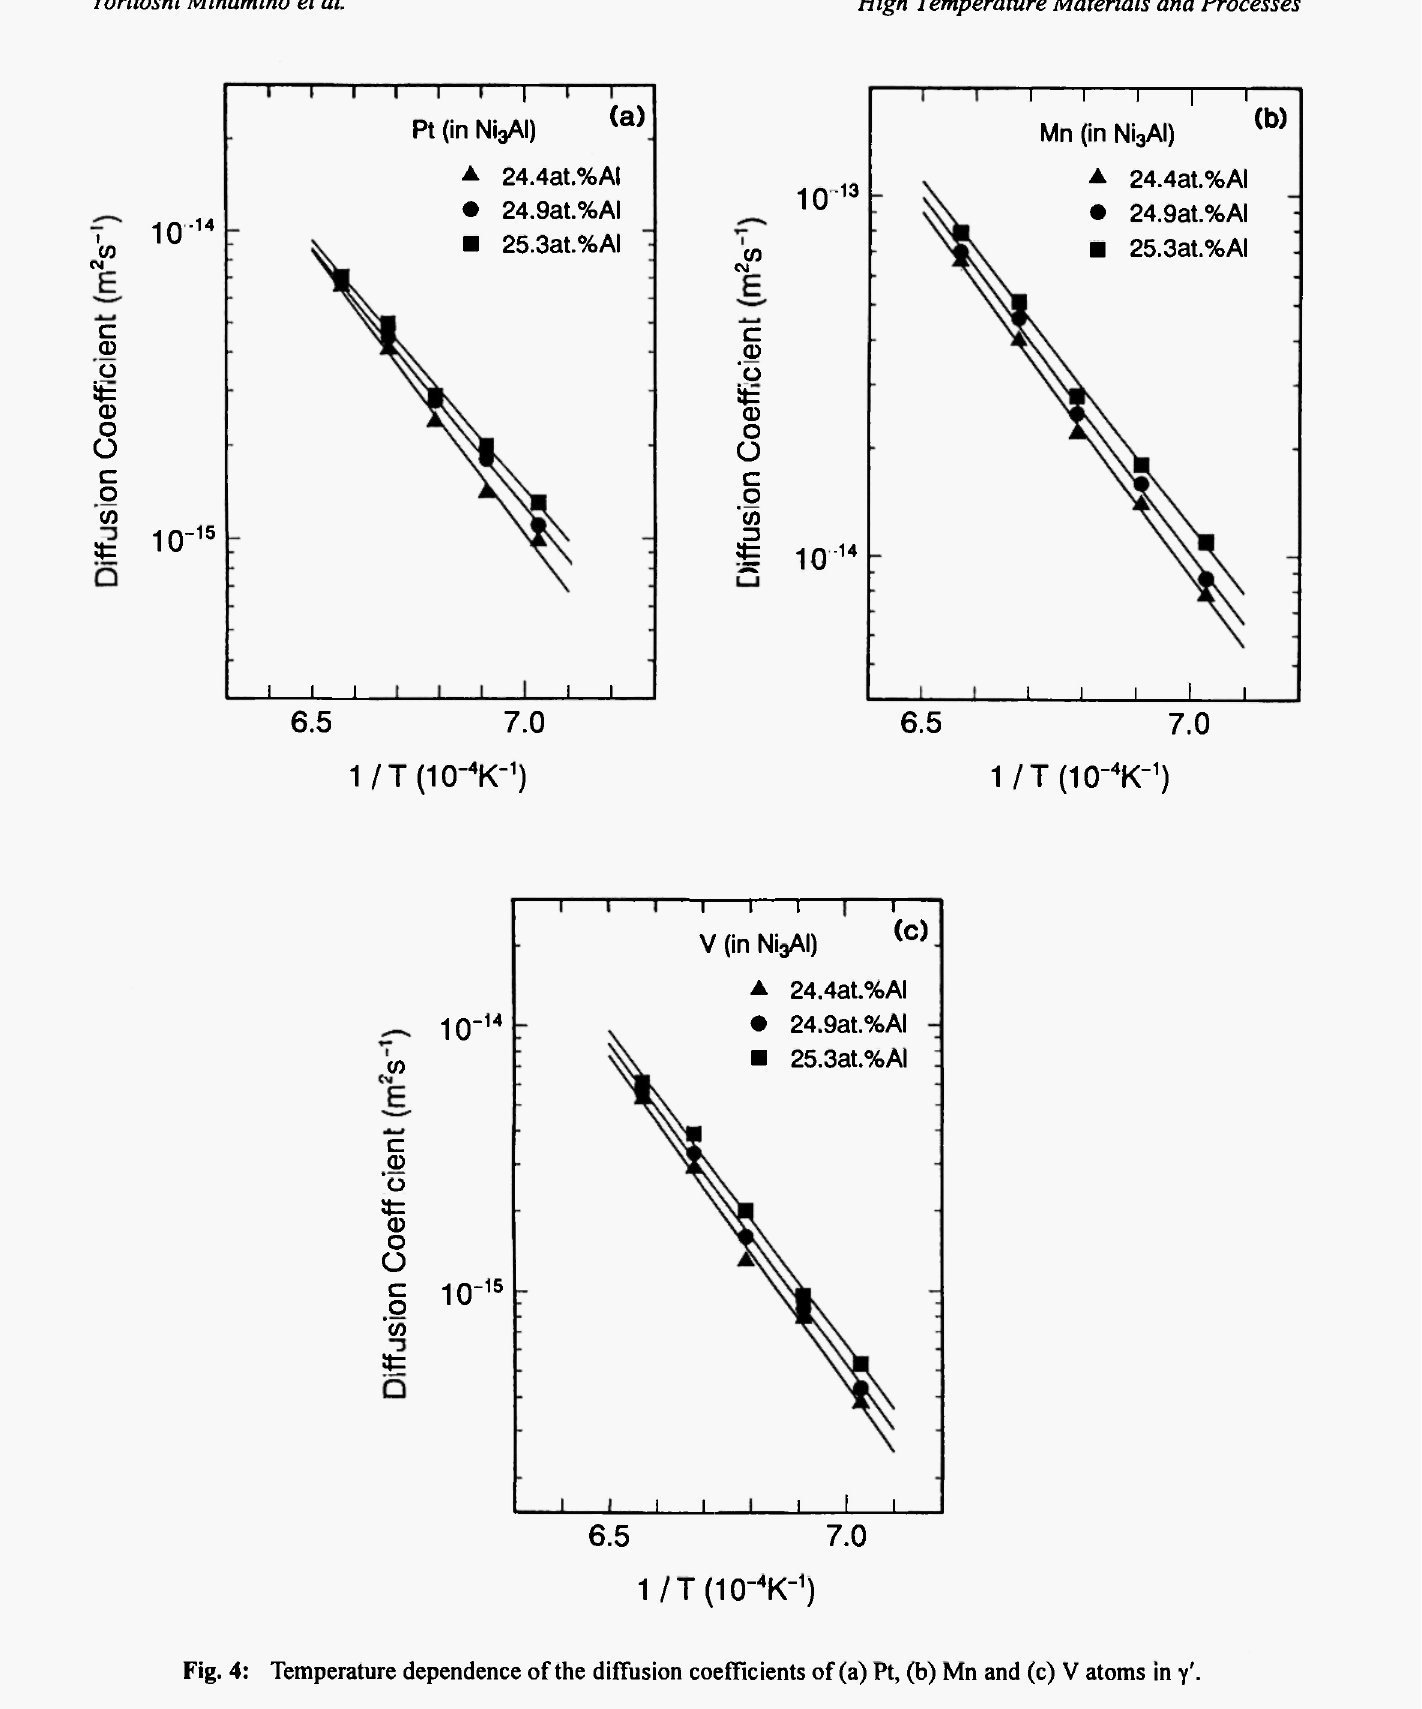
Fig. 4: Temperature dependence of the diffusion coefficients of (a) Pt, (b) Mn and (c) V atoms in γ'.